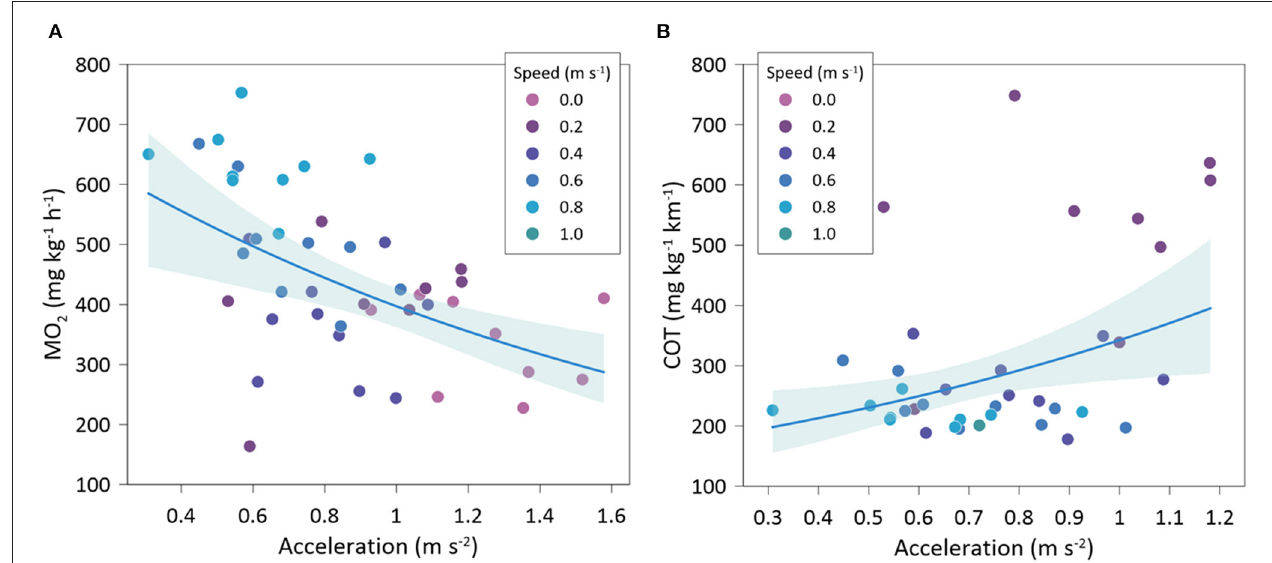
FIGURE 7 | Best-fitted regression accelerations with: (A) oxygen consumption rate (MO 2 ), and (B) cost of transport (COT), of Sparus aurata at different swimming